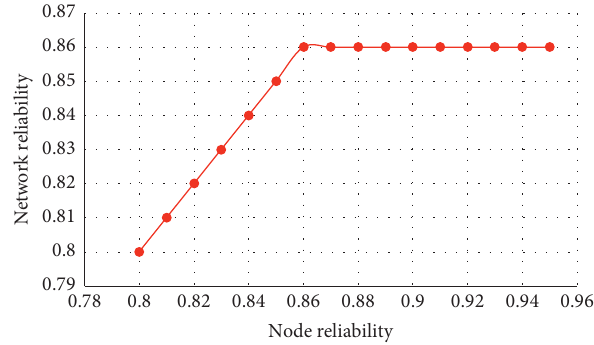
Figure 8: Network reliability vs. node reliability.